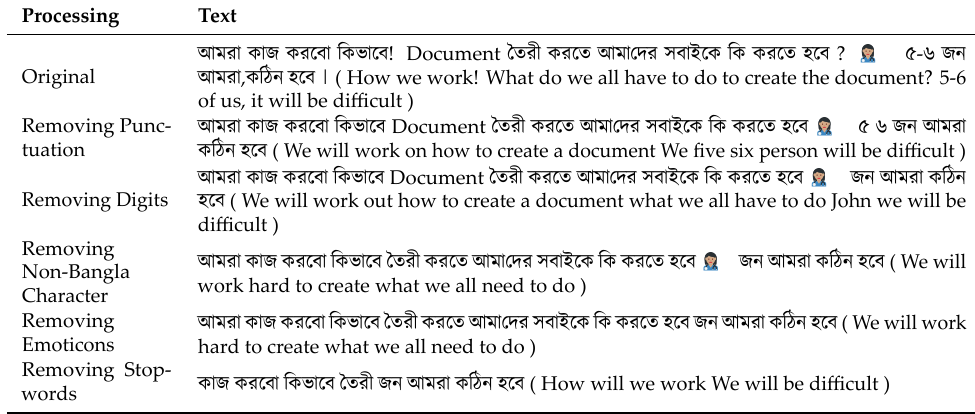
Table 2. Data pre-processing methods, step by